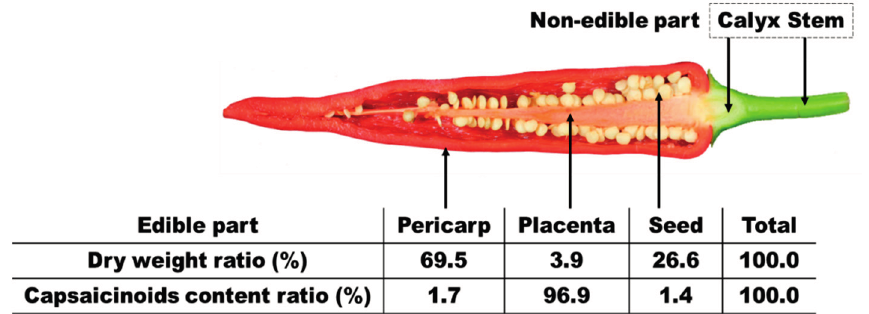
Figure 1. Ratio of the weight and capsaicinoid content for each part of dried Korean red-pepper ( Capsicum annuum